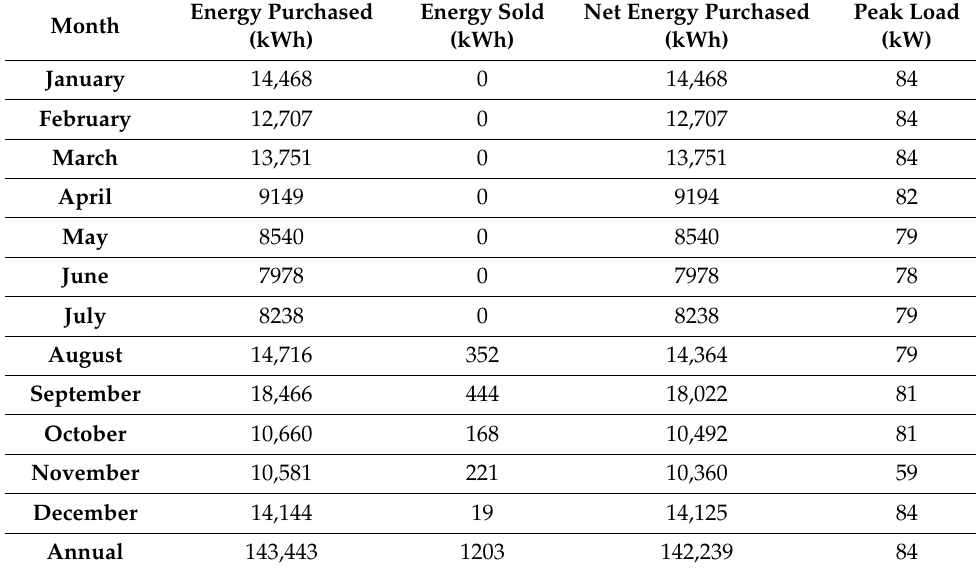
Table 6. Monthly electrical energy purchases and sales by the utility grid and corresponding peak